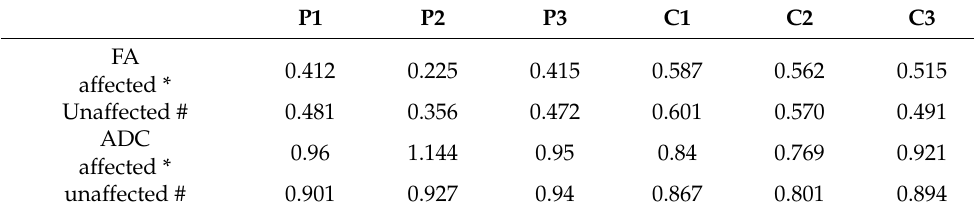
Table 3. Diffusion parameters of diffusion tensor tractography of patients and control